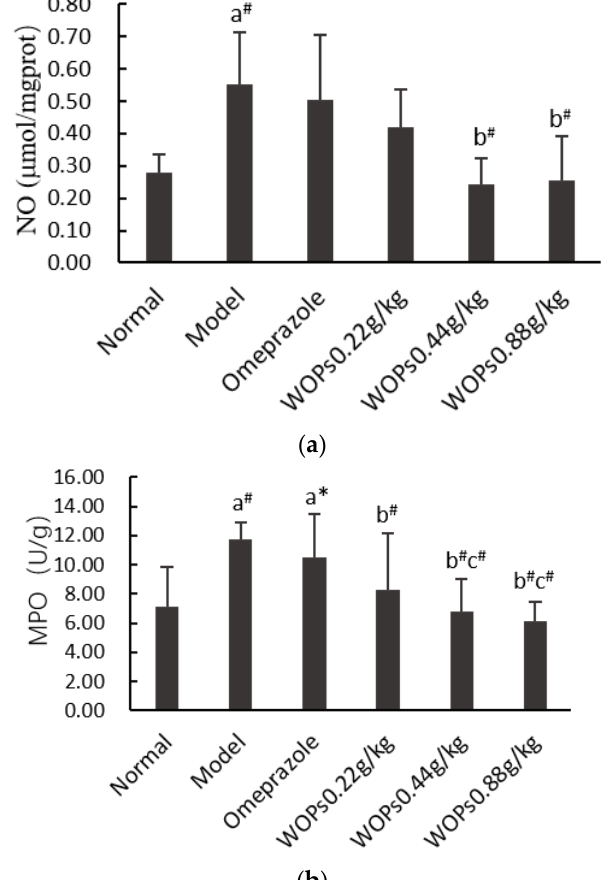
Figure 4. E ff ects of WOPs on gastric NO ( a ) and MPO ( b ) levels in rats. Signi fi cance was represented as * p < 0.05, # p < 0.01; a—compared with normal group, b—compared with model group, c—compared to the omeprazole group; 10 per group. NO—nitric oxide; MPO—myeloperoxidase; WOPs—walnut oligopeptides.